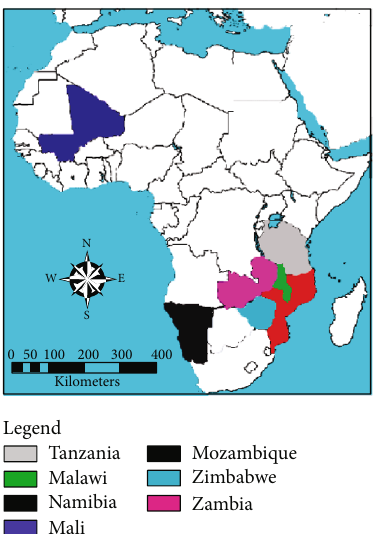
Figure 1: Countries where Sclerocarya birrea seed was collected.